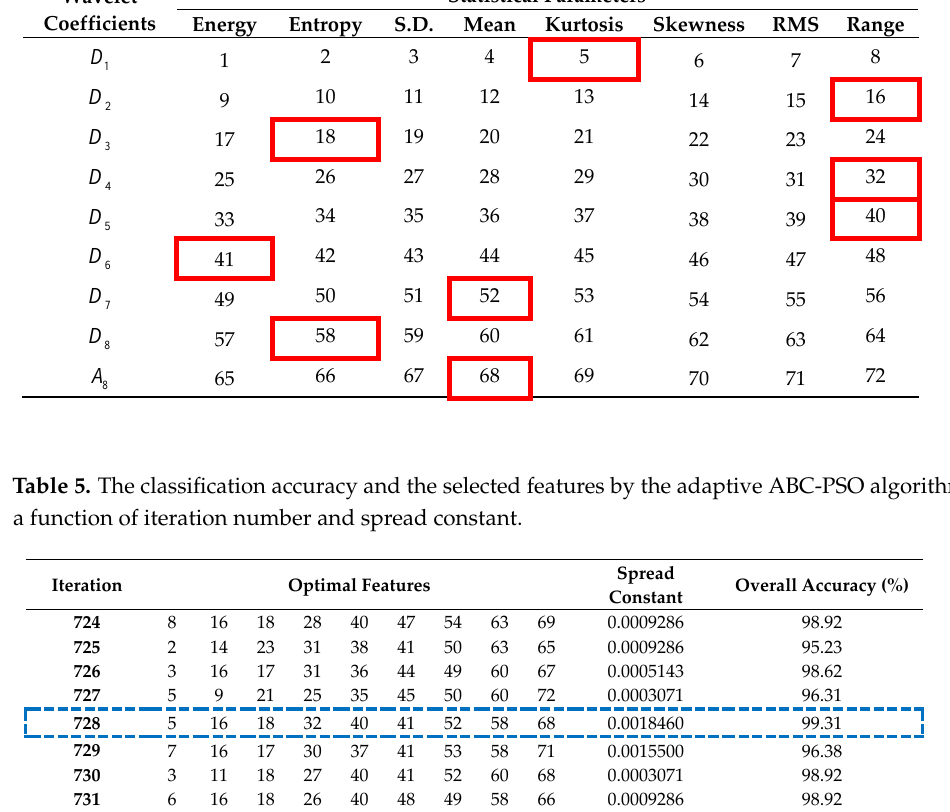
Table 4. The feature vector and the selected features by the adaptive ABC-PSO algorithm.